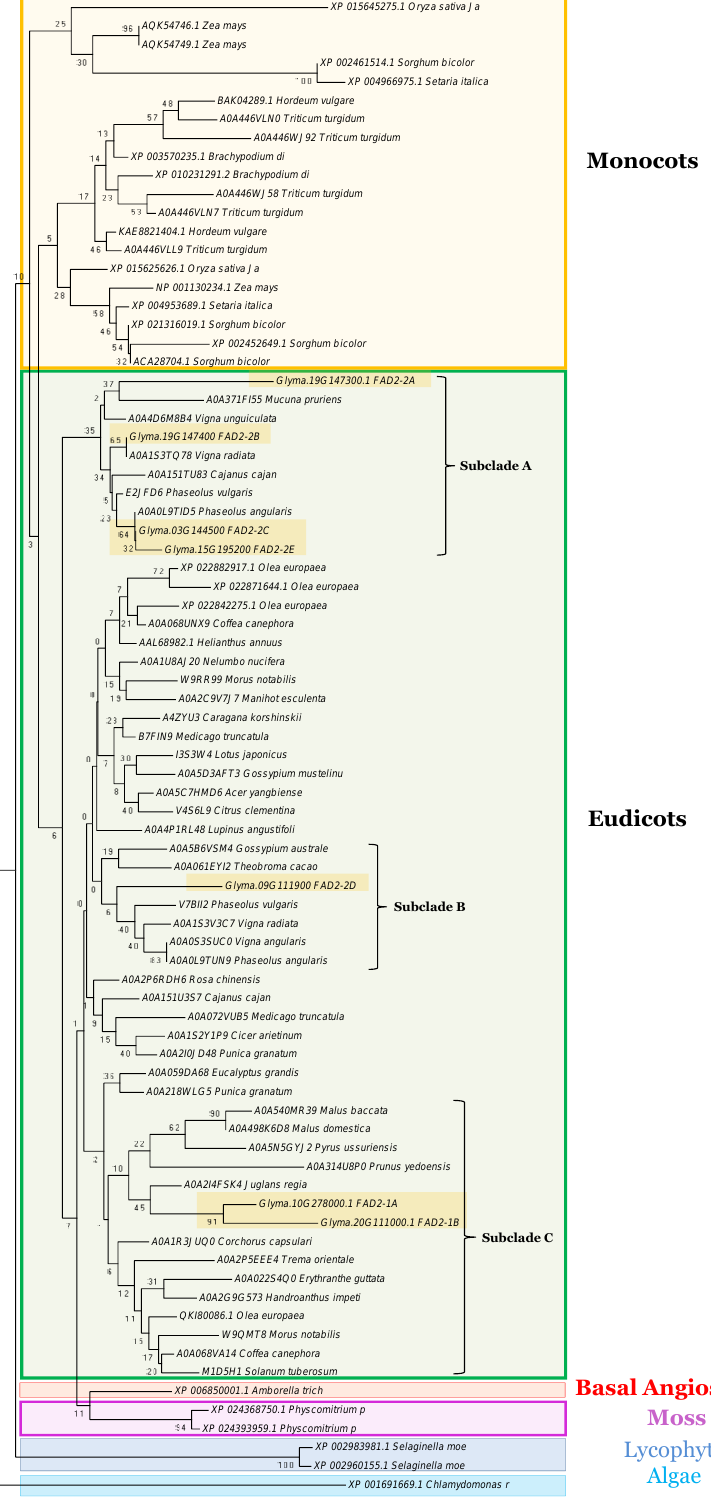
Figure 1. Phylogenetic tree of the fatty acid desaturase-2 from 48 sequenced plant species. FAD2 proteins identified in five model plants; C. reinhardtii (algae; green box), P. patens (moss), S. moellendorfii (lycophyte), O. sativa (monocot), and M. truncatula (eudicot leguminous), in addition to G. max (soybean) and other monocots and eudicots FAD2s were included in the analysis. The phylogenetic tree was generated using MEGA4 software package and the ClustalW algorithm and calculated using the neighbor-joining method. The tree bootstrap values are indicated at the nodes ( n =